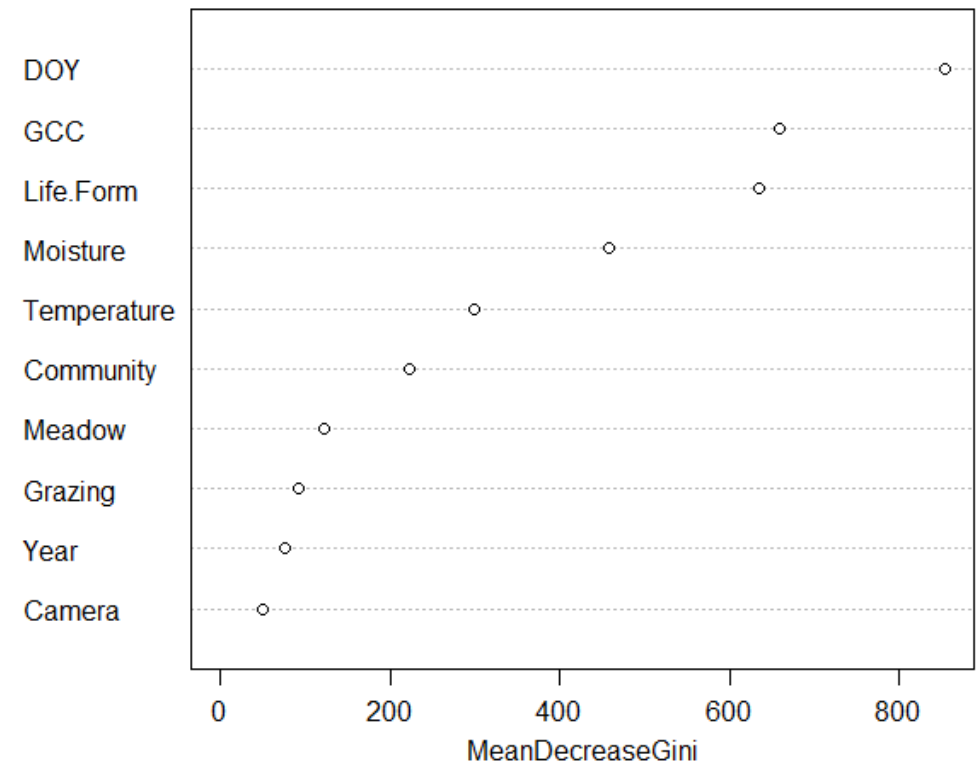
Figure 3. Importance of variables used to create a random forest model for the prediction of phenological stages in the meadows. Importance was calculated based on mean decrease of Gini.